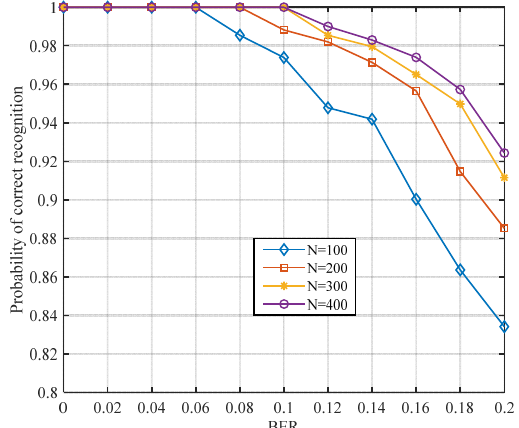
Figure 12. Influence of number of samples on the recognition rate.